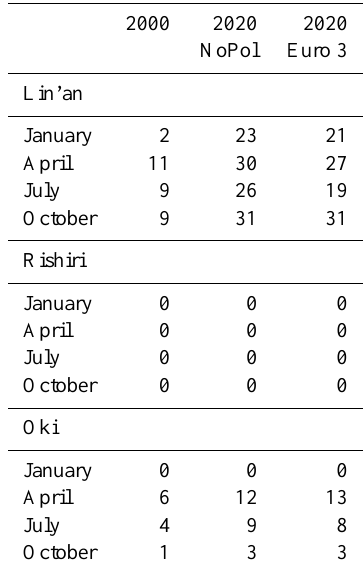
Table 9b. Days exceeding the WHO interim target-1 standard for PM 2 . 5 (35µgm − 3